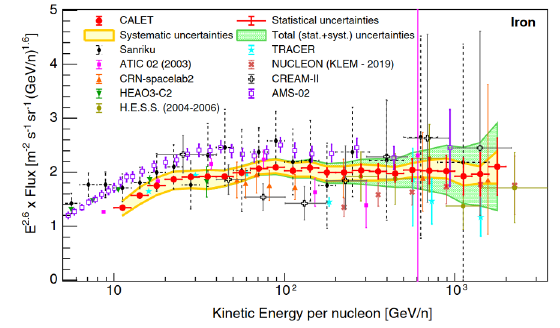
Figure 8. Iron spectrum measured by several experiments [19].